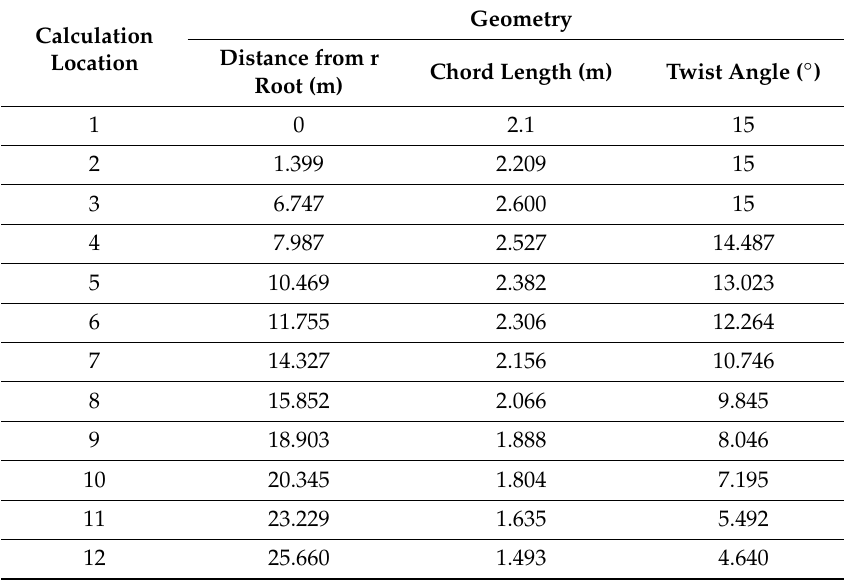
Table 2. Baseline blade geometry and calculation